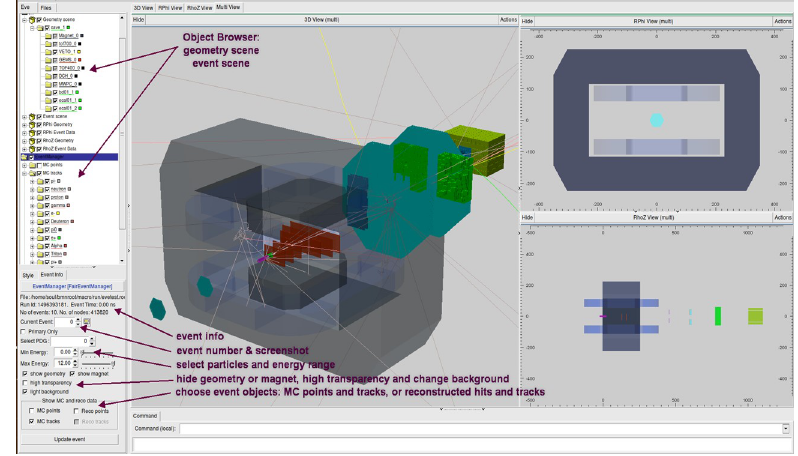
Fig. 6. Views and projections of the BM@N setup in developed event